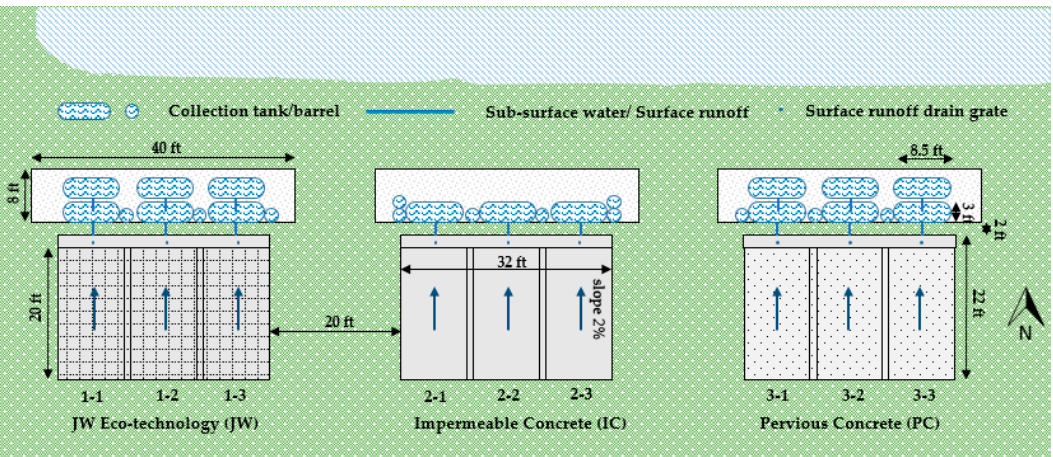
Figure 4. Overview of the three pavement systems at the project site, from left to right, JW Eco- technology, impervious concrete, and pervious